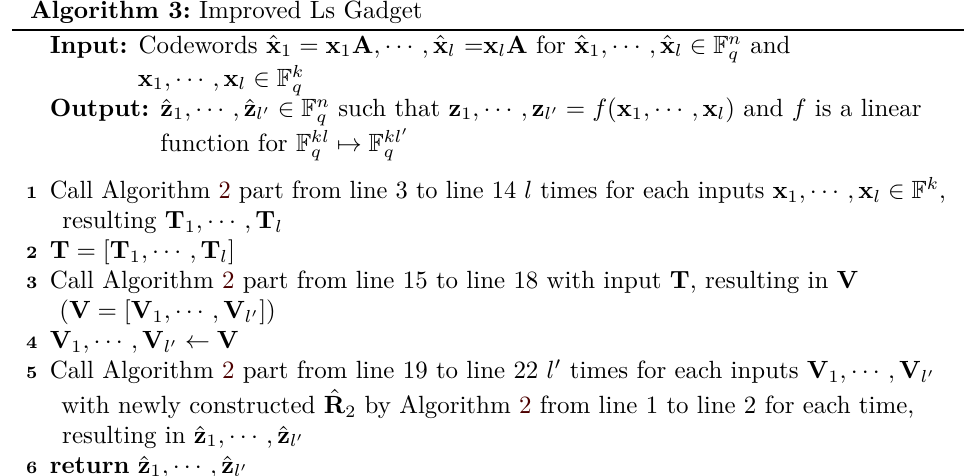
Algorithm 3: Improved Ls